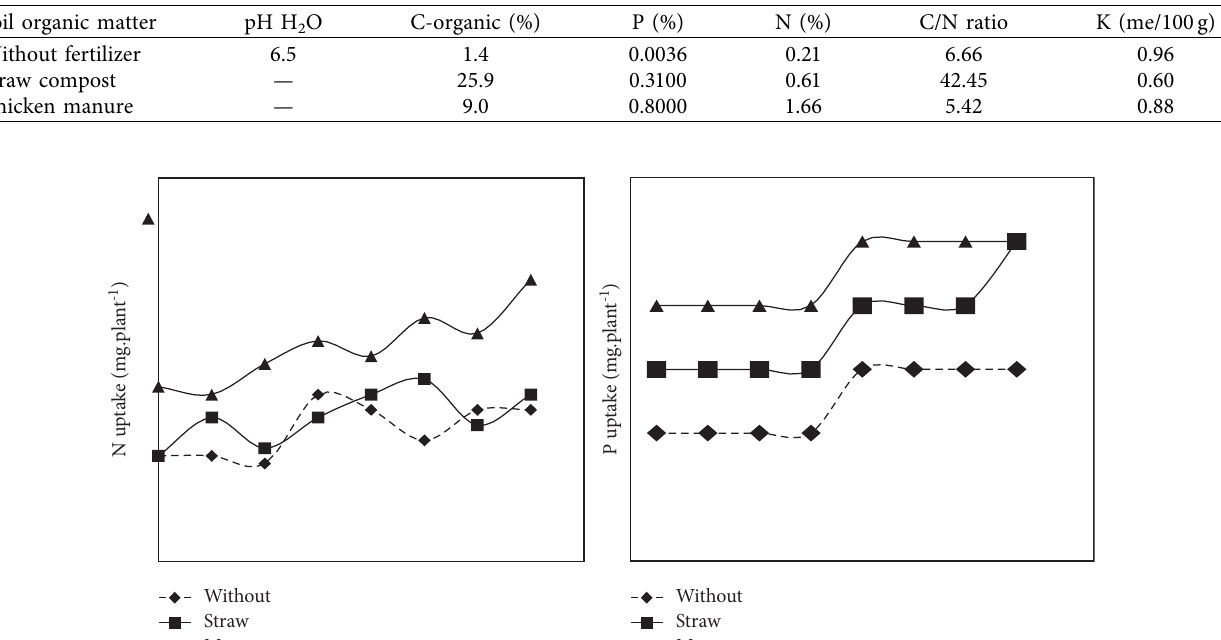
Figure 2: Effect of urea: 25 kg · ha − 1 (25 N) and 50kg · ha − 1 (50 N), SP36: 75 kg · ha − 1 (75 P) and 100kg · ha − 1 (100 P), and biofertilizer (Bio) on